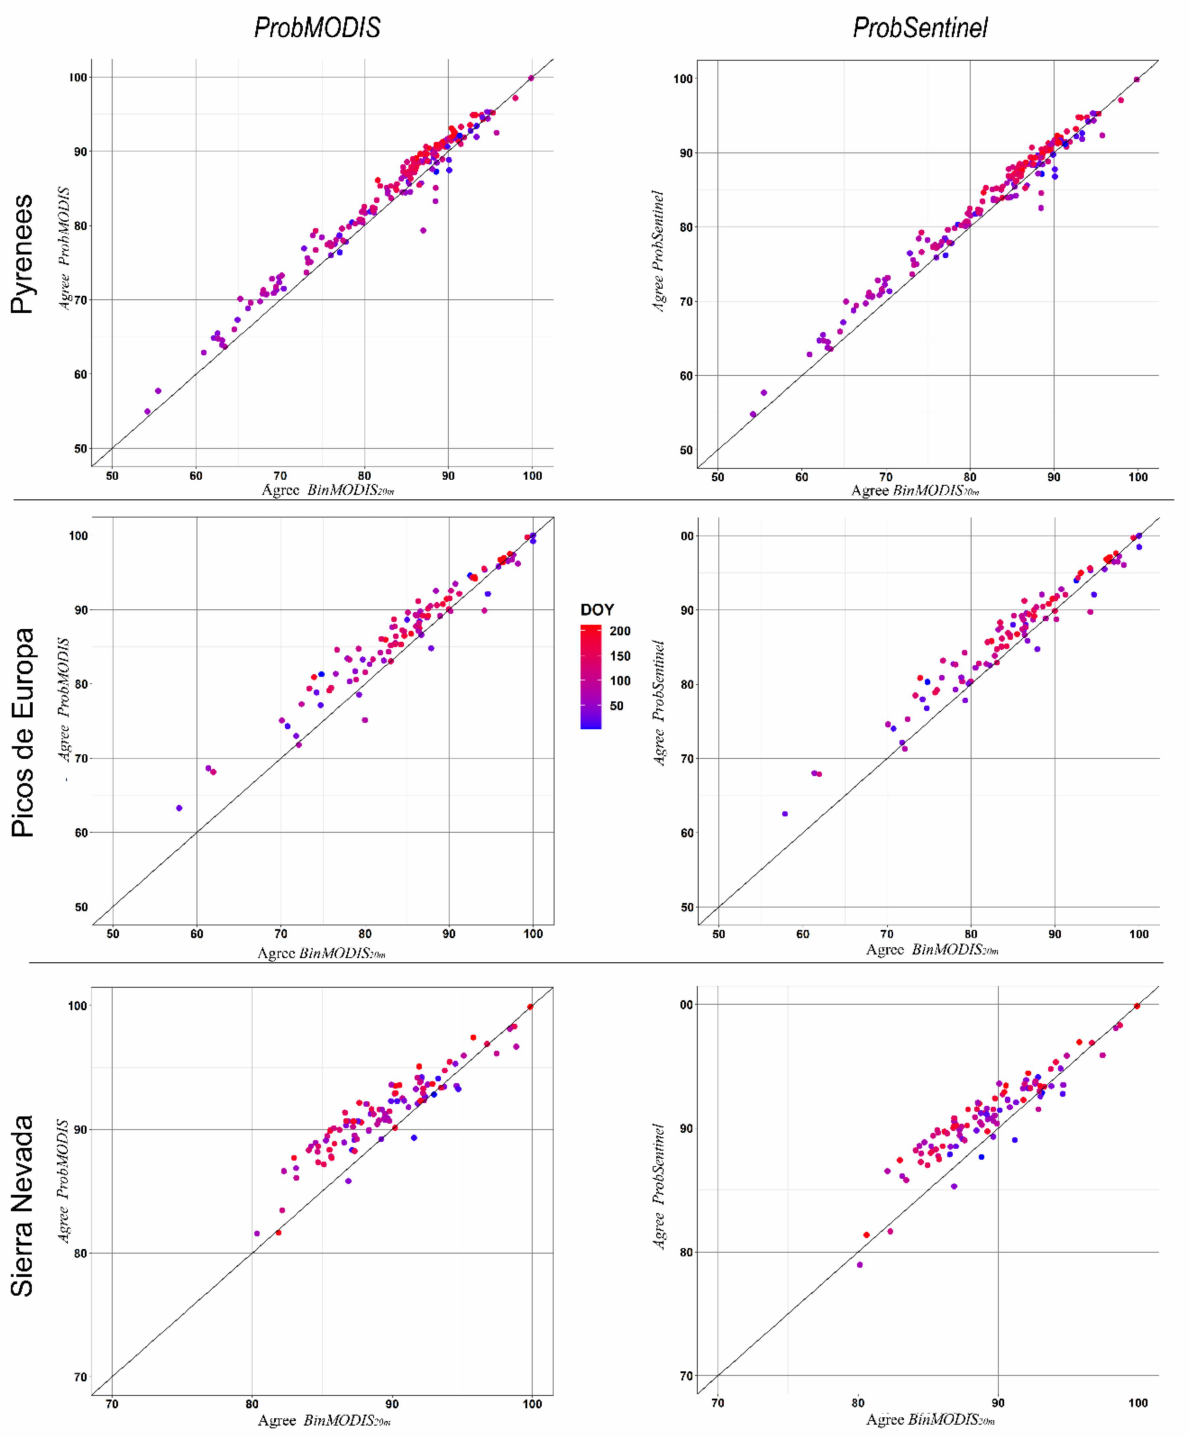
Figure 7. Percentage of agreement scatter plot of ProbMODIS (left panel graphs) and ProbSentinel (right panel graphs) versus percentage of agreement of BinMODIS 20m . The color scale depicts the day of the snow season (Day Of Year starting October